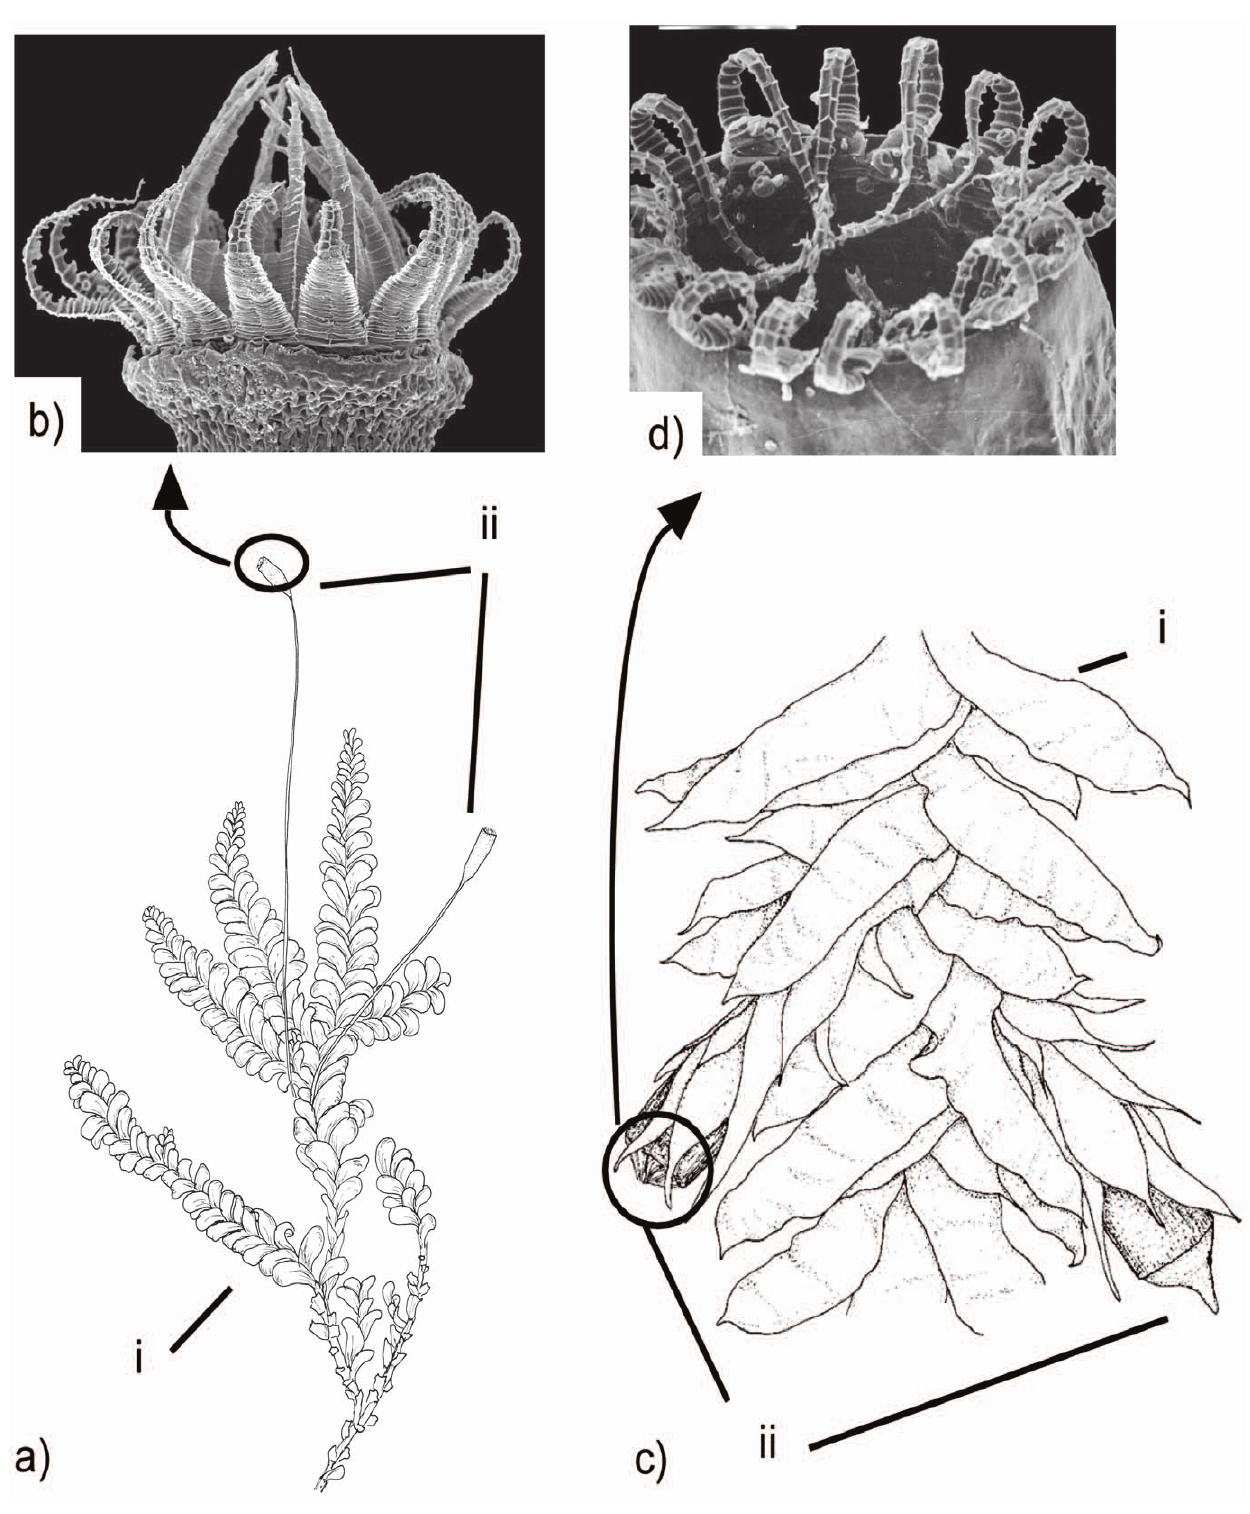
Figure 1. Sporophyte structure in Neckeraceae. Example of a perfect and a specialized sporophyte structure in Neckeraceae. a) Homalia trichomanoides gametophyte (i) and sporophytes (ii) with long setas and slightly inclined capsules; b) SEM view of well-developed hypnalean peristome in H. trichomanoides . c) Neckera pennata gametophyte (i) and sporophytes (ii) that have short setas immersed in perichaetial leaves and upright capsules; d) SEM view of reduced peristome in N. pennata . Pictures reprinted with permission of M. S. Ignatov and E. Ignatova.